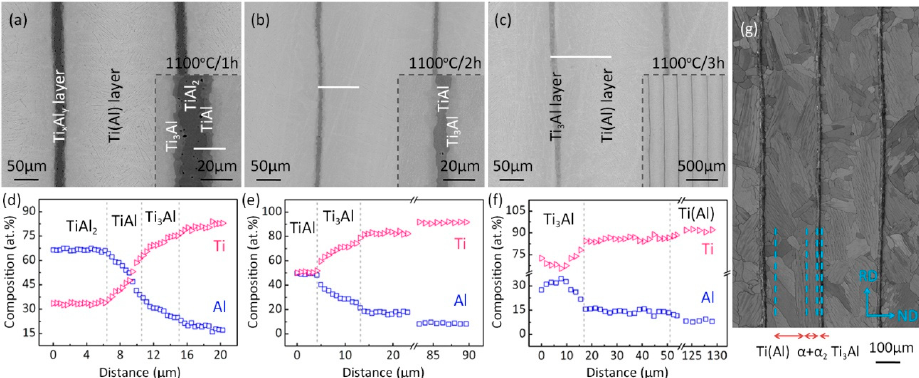
Figure 4. Microstructure evolution of Ti-Al layered composites during fabrication process [31]. ( a – f ) SEM micrographs and energy dispersive X-ray spectroscopy (EDX) line scan (along white lines in ( a – c ), from left to right) of the samples annealed at 1100 °C for: ( a , d ) 1 h; ( b , e ) 2 h; and ( c , f ) 3 h. The samples were initially heated treated at 700 °C for 1 h before high temperature annealing. ( g ) Kikuchi band contrast map retrieved from the electron backscattered diffraction (EBSD) results. The spatial coordinate system is represented by rolling (RD), normal (ND), and transverse (TD) directions.